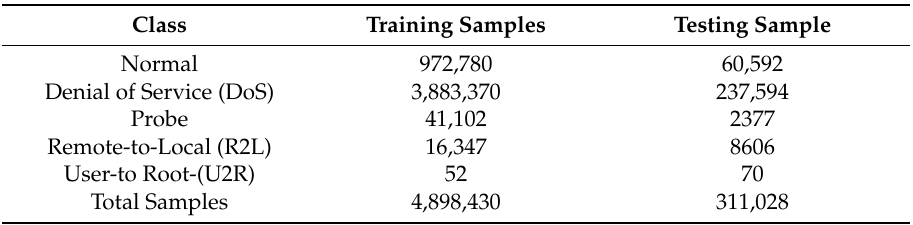
Table 1. KDD ’99 dataset descriptions.